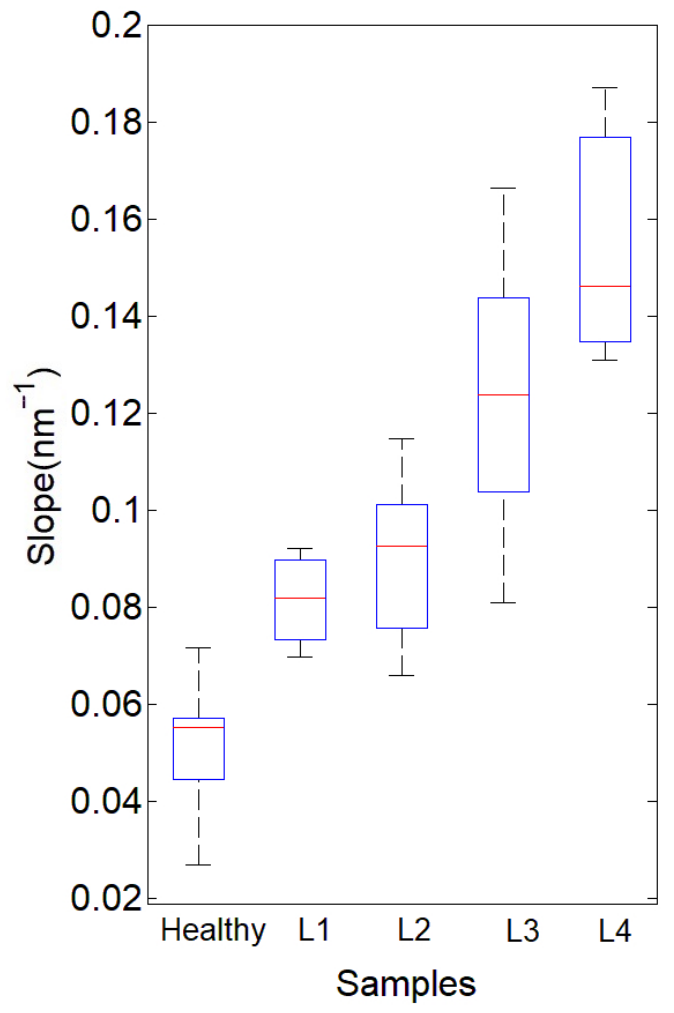
Figure 4. Boxplot and whisker plot of the slope data. Healthy samples, L1, L2, L3, and L4.